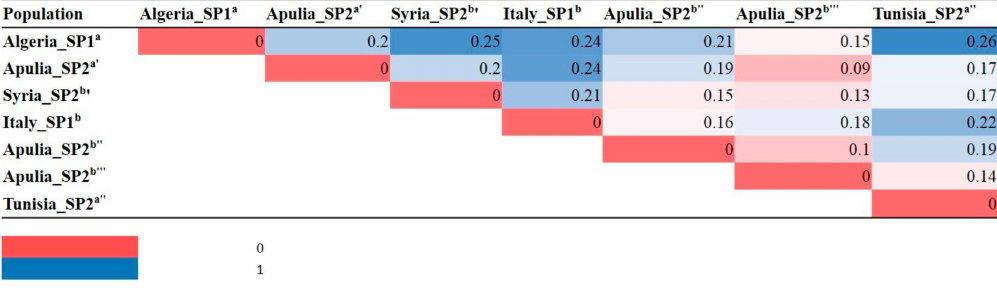
Figure 3. Genetic di ff erentiation (F ST ) between subpopulations detected by STRUCTURE at K =